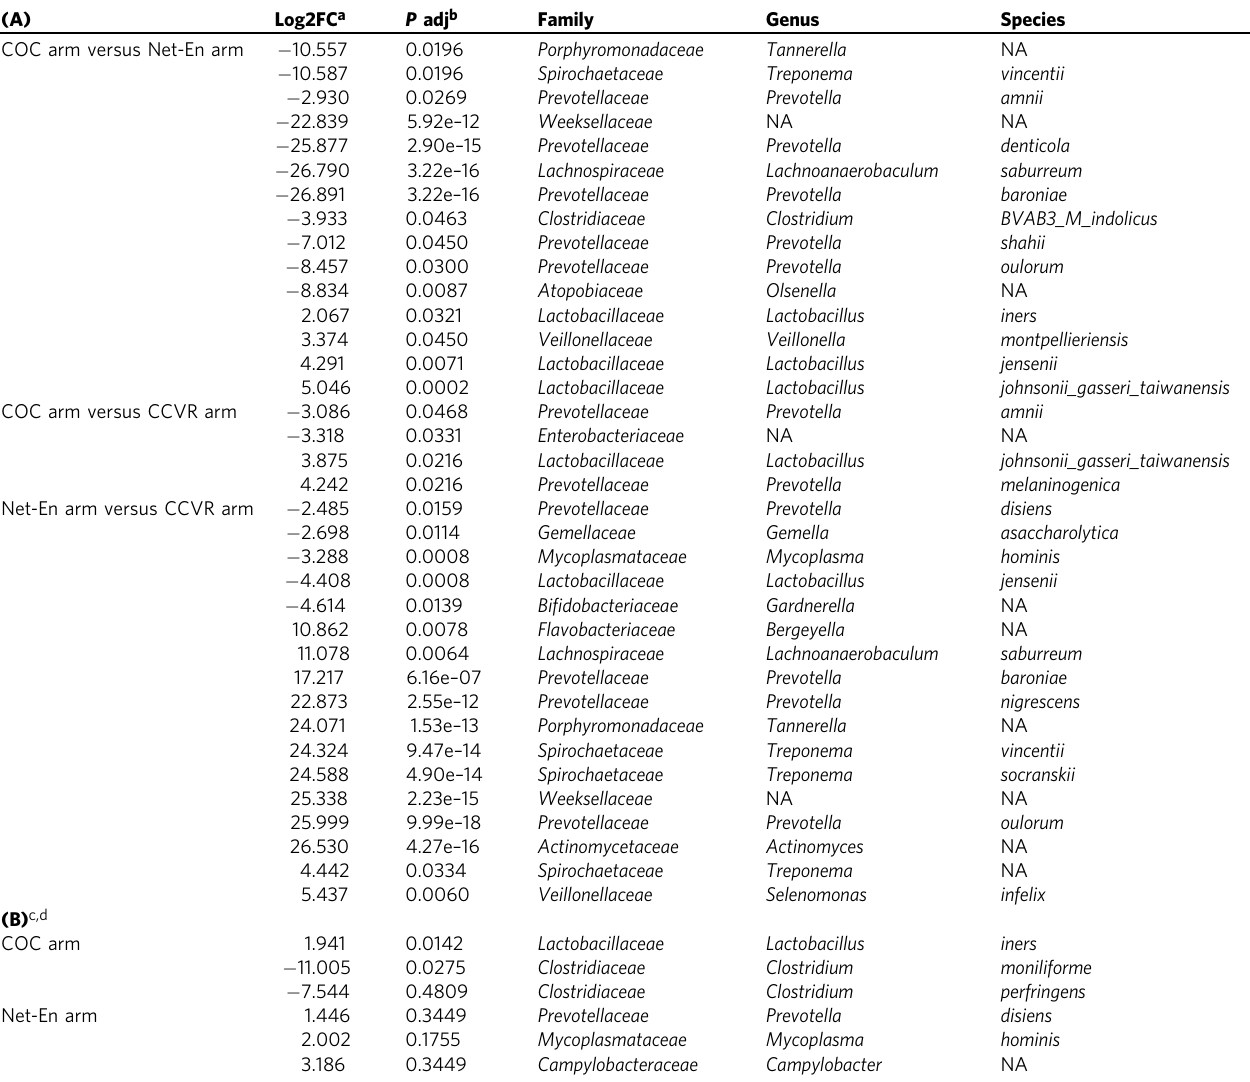
FC: fold change, CCVR: combined contraceptive vaginal ring (A: n = 32, B: n = 32 matched participants), COC: combined oral contraceptives (A: n = 35, B: n = 34 matched participants), Net-En (A: n = 28, B: n = 32 matched participants). a Positive fold changes represent taxa more abundant in the fi rst hormonal contraceptive arm. b Taxa with an adjusted P <0.05 after adjusting for condom use and antibiotic use included. c Positive fold changes represent taxa more abundant at crossover. d Taxa with an adjusted P <0.5 included. Source data are provided as a Source Data fi